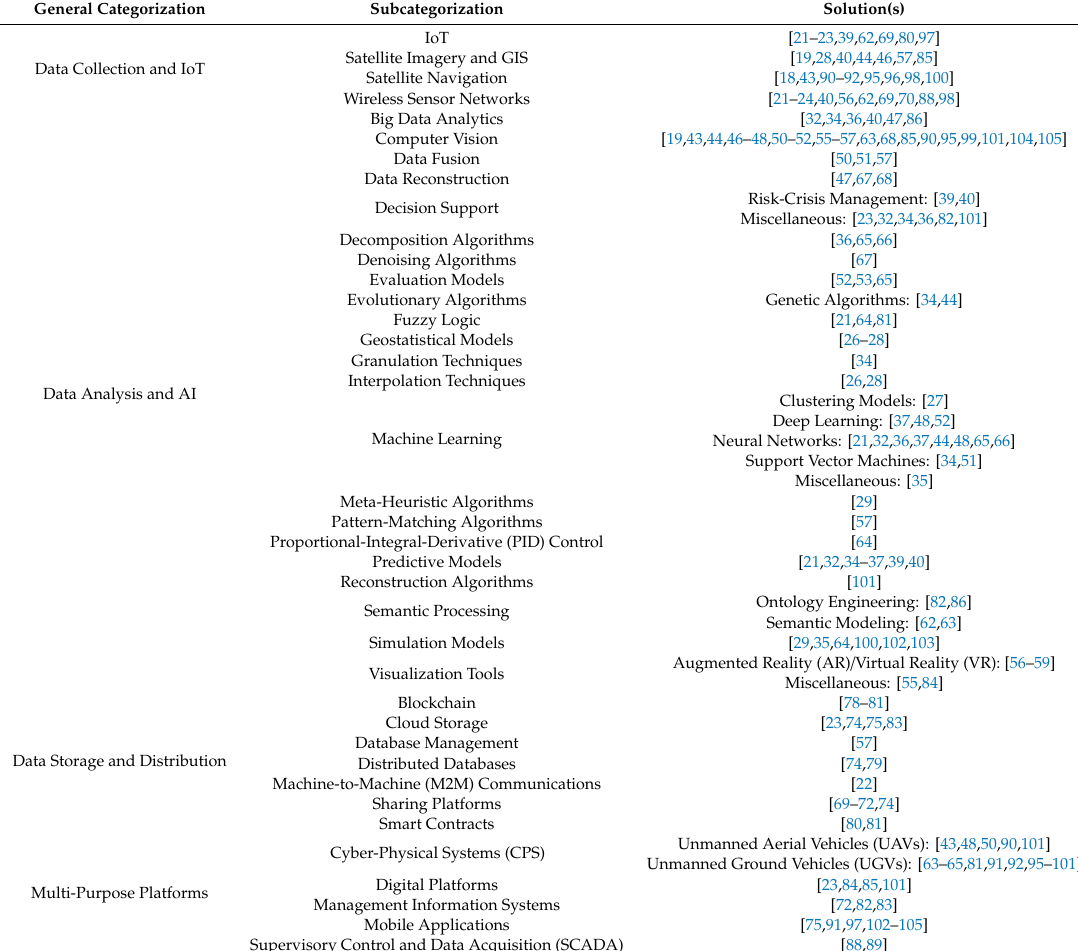
Table 1. Categorization of the Analyzed information and communication technology (ICT) solutions for precision agriculture